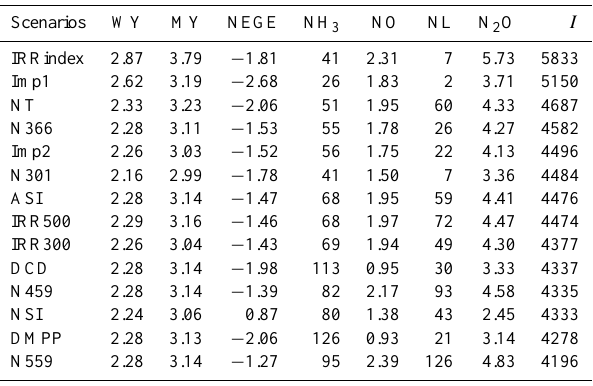
Table 4. Modeled goal variables (annual averages over 20yr sim- ulation) and values of assessment index ( I ) for each management practice scenario.